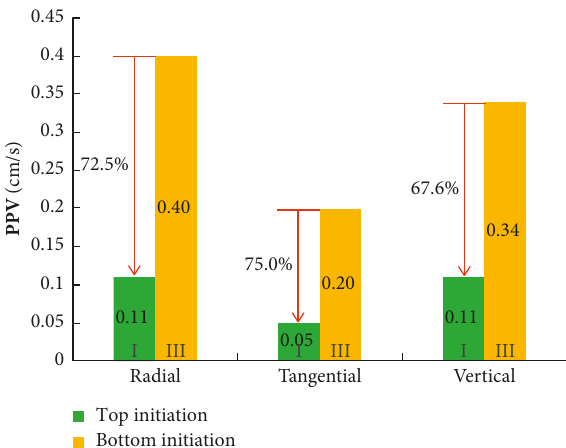
Figure 22: Comparison of PPV s measured at the ground surface (#4) in the single-hole blasting experiment.